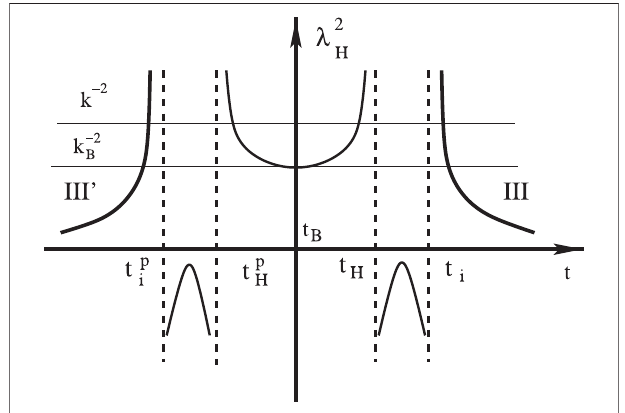
FIGURE6| Schematicplotof λ 2 H de fi nedby Eq.3.25 vs. t formLQC-II in the dressed metricapproachforthe quadratic and theStarobinskypotentials, where a ’’ ( t p H ) (cid:2) a ’’ ( t H ) (cid:2) 0 and a ’’ ( t p i ) (cid:2) a ’’ ( t i ) (cid:2) 0, and t (cid:2) t i denotes the starting time of the in fl ationary phase, while t (cid:2) t p i is the end time of the de fl ationary phase in the contracting branch. During the slow-roll in fl ation, we have λ 2 H ≈ L 2 H / 2. In particular, λ 2 H is decreasing (increasing) exponentially in Region III (Region III ′ ). The corresponding effective mass near the bounce is always negative. Similar behavior also happens in LQC in the dressed metric approach (Zhu et al., 2017). The bounce is dominated by the kinetic energy of the scalar fi eld, which leads to t p H ≈ − t H . However, in general we fi nd that t